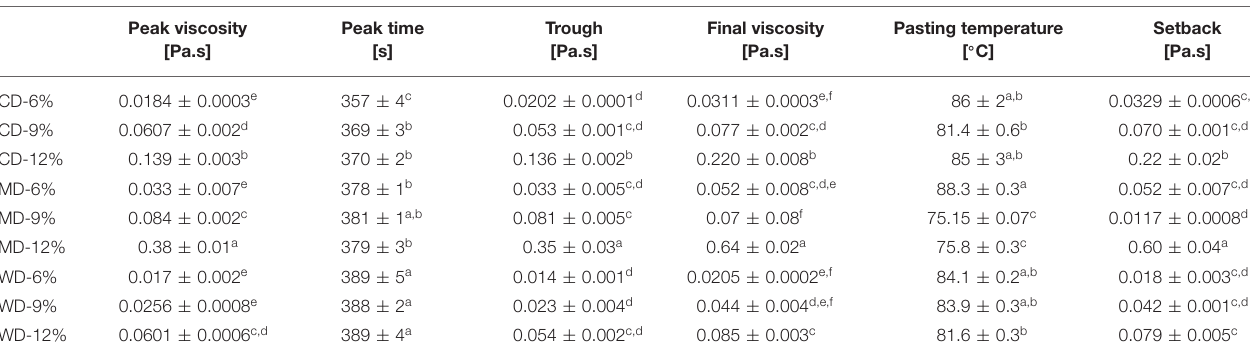
TABLE 2 | Pasting properties of hyperprotein flour dispersions.